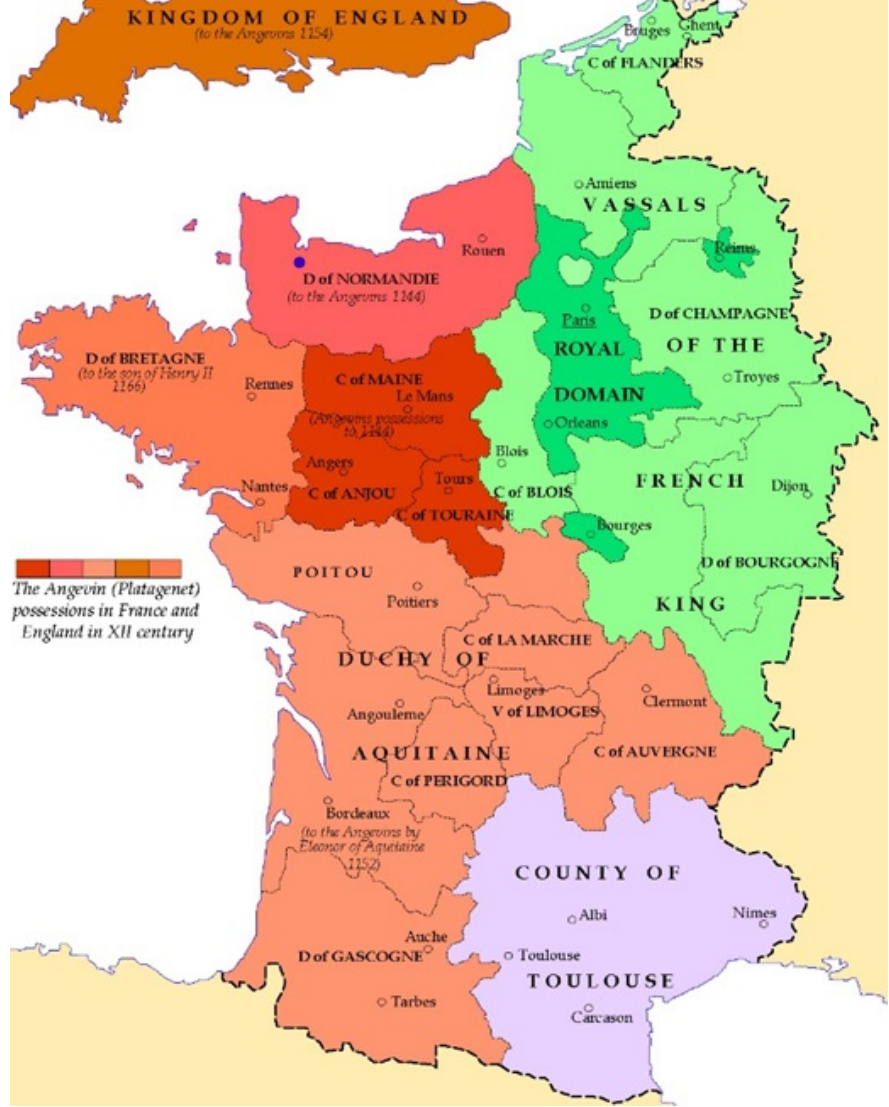
Figure 1. Map of the Angevin Empire’s continental holdings during the twelfth and thirteenth centuries. The blue dot indicates Saint-Lô’s location in Normandy. Wikipedia Commons. https://commons.wikimedia.org/wiki/File:France_1154_Eng.jpg (accessed on 12 September 2021).